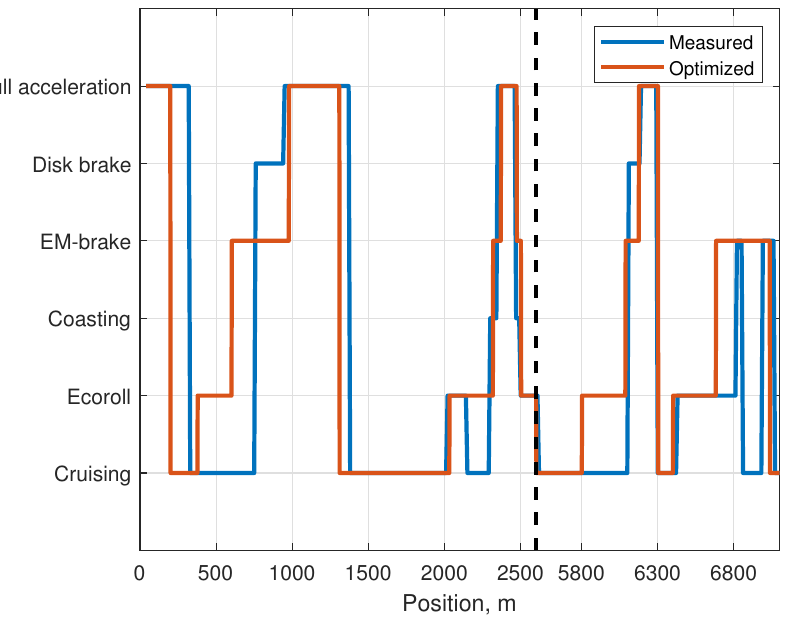
Figure 6. Driving modes of human test drive (blue line) and MATLAB simulator (orange line). Two selected segments are shown.